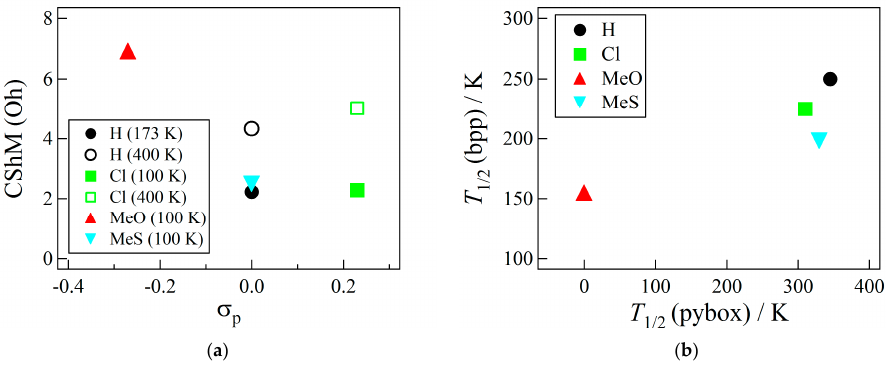
Figure 4. Relations between ( a ) the distortion parameter CShM (continuous shape measures) and Hammett substituent constant σ p . ( b ) Plot of T 1/2 for polycrystalline [Fe(X-1-bpp) 2 ](ClO 4 ) 2 vs. T 1/2 for solution [Fe(X-pybox) 2 ](BF 4 ) 2 . The [Fe(X-1-bpp) 2 ](BF 4 ) 2 data are taken from Ref. [32].